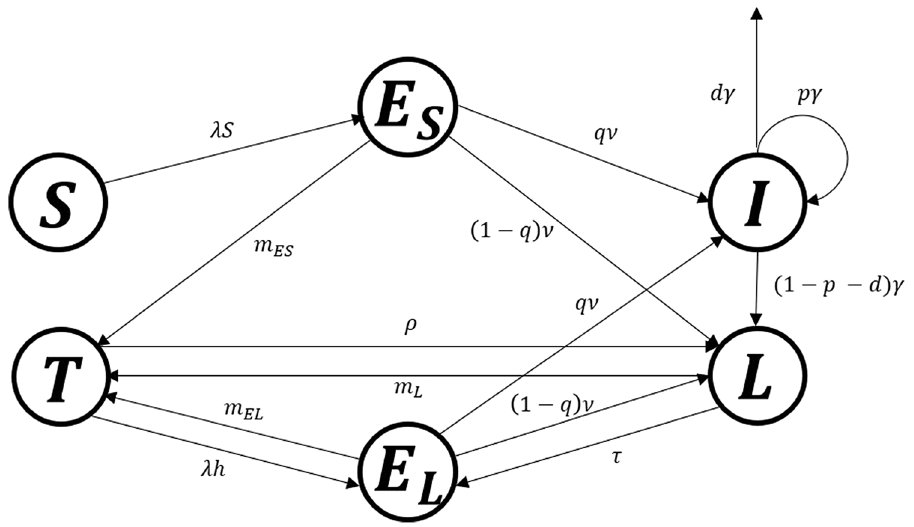
Figure 2. Flow diagram for the TB transmission